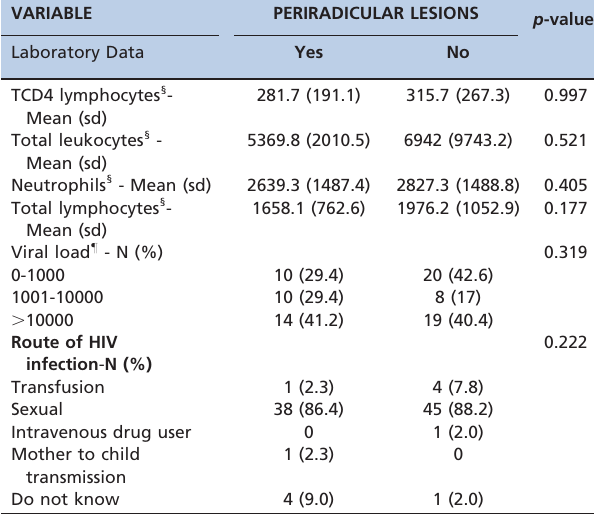
Table 2 - Bivariate analysis between periradicular lesions and the laboratory data of the study population.